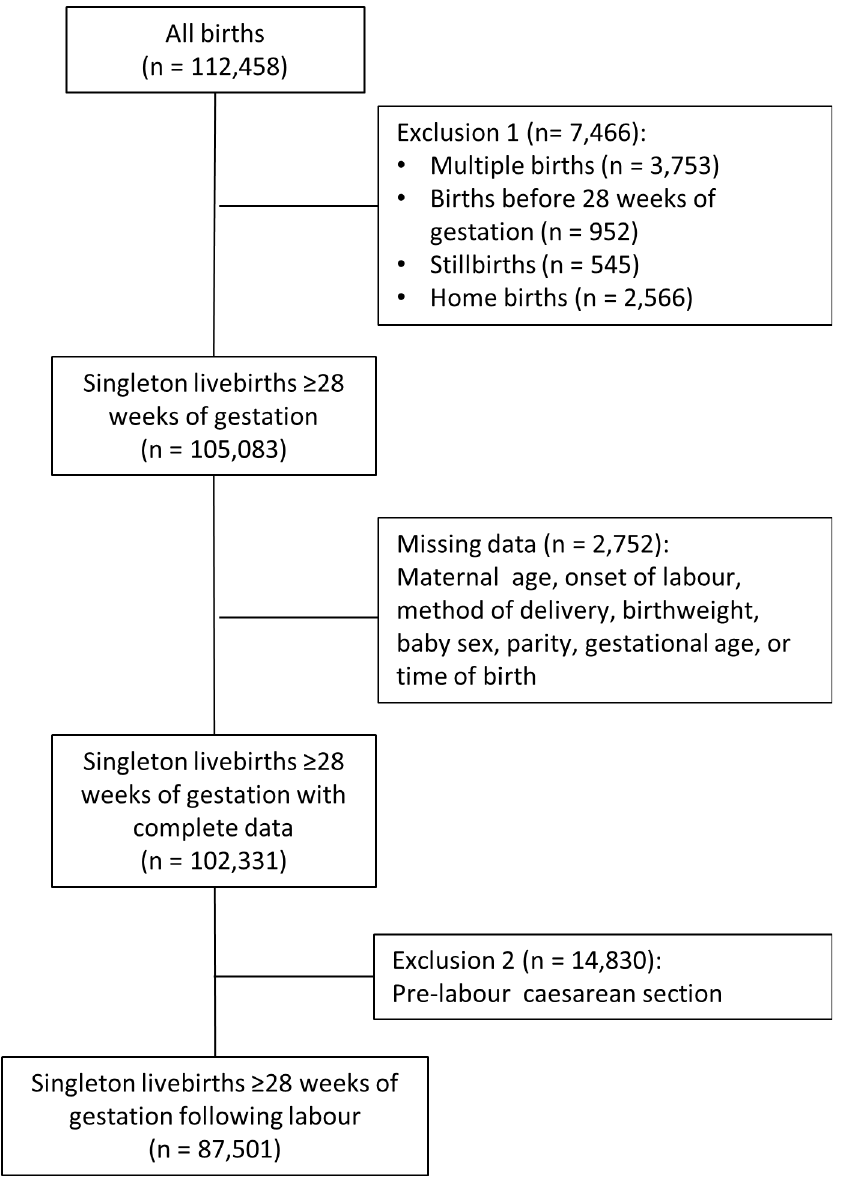
Fig 1. Selection of the